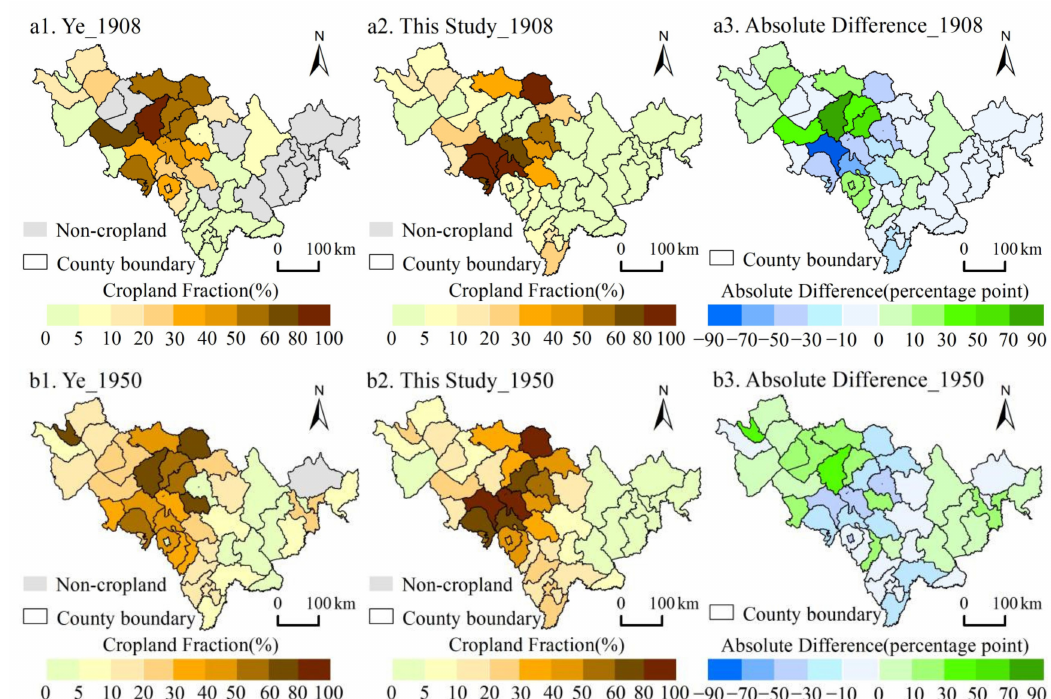
Figure 9. The spatial distribution of cropland fractions derived from Ye et al. [48] ( a1 , b1 ) and from this study ( a2 , b2 ) at the county scale. The absolute differences between cropland fractions derived from Ye et al. [48] and this study ( a3 , b3 ).